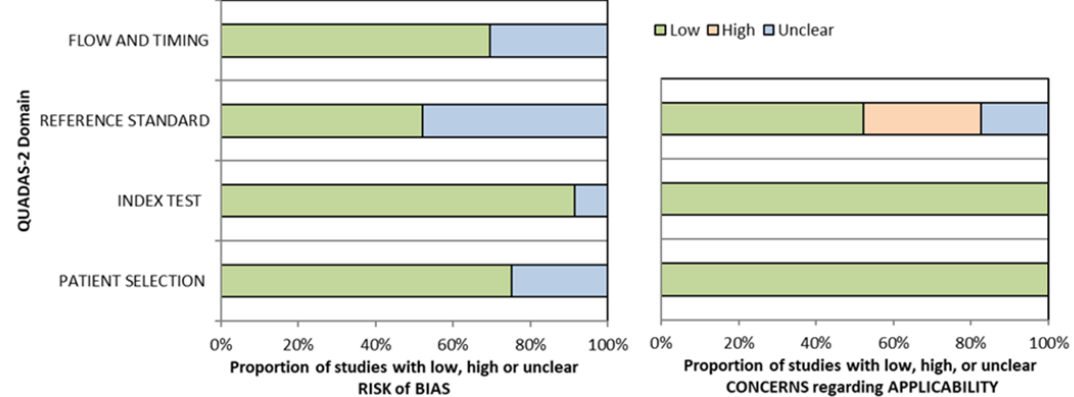
Figure 6. Stacked bar charts of risk of bias assessment according to QUADAS-2 [21]. Study quality expressed as percentage of studies showing low (green), unclear (blue) and high (red) potential of bias in four domains.